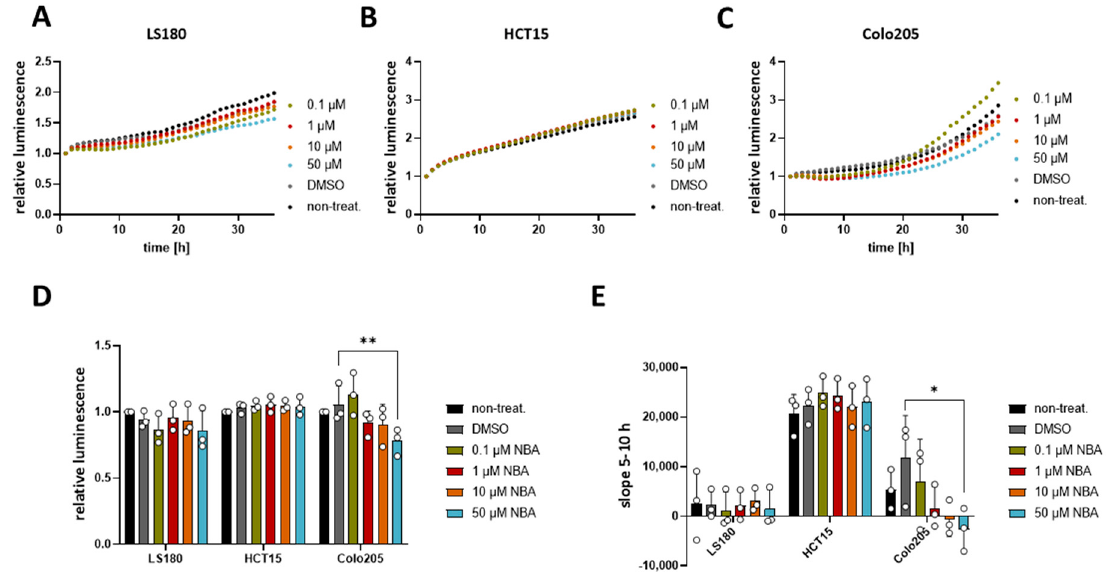
Figure 6. Effect of NBA on CRC cells’ viability. Cell viability in LS180, HCT15, and Colo205 cells was evaluated using a RealTime-Glo MT assay. Cells were treated with 0.1 µ M, 1 µ M, 10 µ M, 50 µ M NBA, or DMSO control. Three independent experiments were performed. ( A ) Mean of relative luminescence was plotted versus time for LS180 cells. ( B ) Same for HCT15 cells. ( C ) Same for Colo205 cells. ( D ) Scatter plot and bar diagram of data (mean + SD) at 24 h from three independent experiments in ( A – C ). ( E ) Scatter plot and bar diagram of slope steepness between 5 and 10 h (mean + SD) from data in ( A – C ). One-way ANOVA was used to determine statistical significance (* p < 0.05, ** p < 0.005) in ( D , E ).